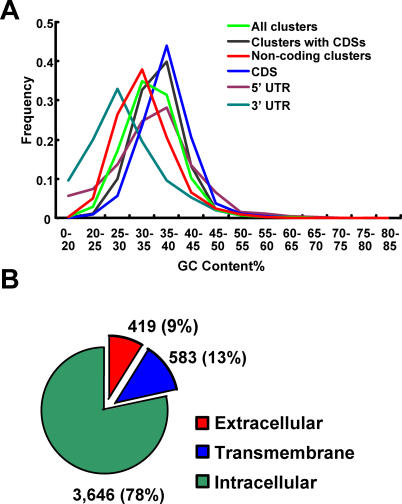
Characteristics of S. japonicum Clusters with Potential CDSs(A) A comparison of GC content among all clusters, clusters with protein-coding genes, non-coding clusters, protein-coding regions, and 5′ and 3′ UTRs.(B) The subcellular localization of putative proteins deduced from complete CDSs and hypothetical genes predicted with the bioinformatics tools SignalP, TMHMM, and PSORT II.